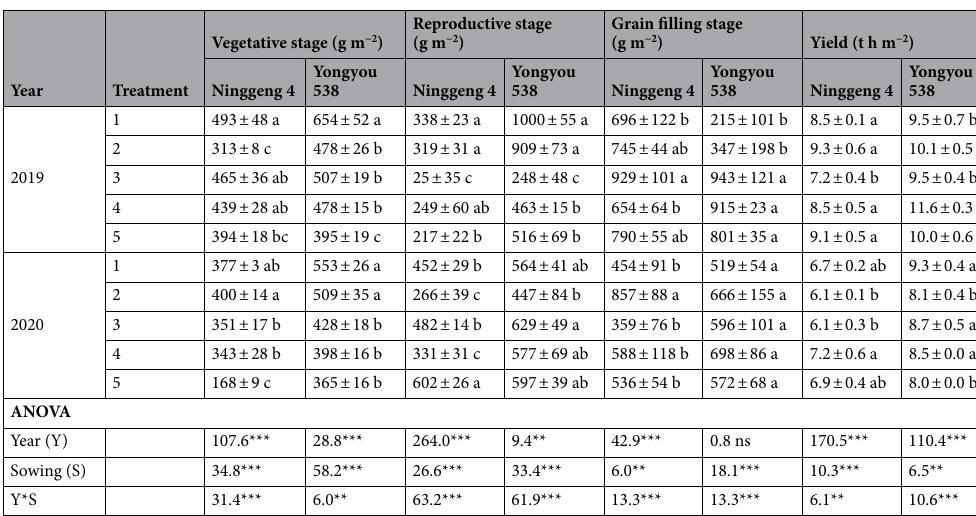
Table 1. Difference in biomass and yields of different treatments from 2019 to 2020. Data are mean and sd. Means followed by different letters at the same year are significantly different according to Tukey’s HSD test ( P < 0.05). ***Means P < 0.001; **means 0.001 ≤ P < 0.01; *means 0.01 ≤ P < 0.05; ns means P ≥